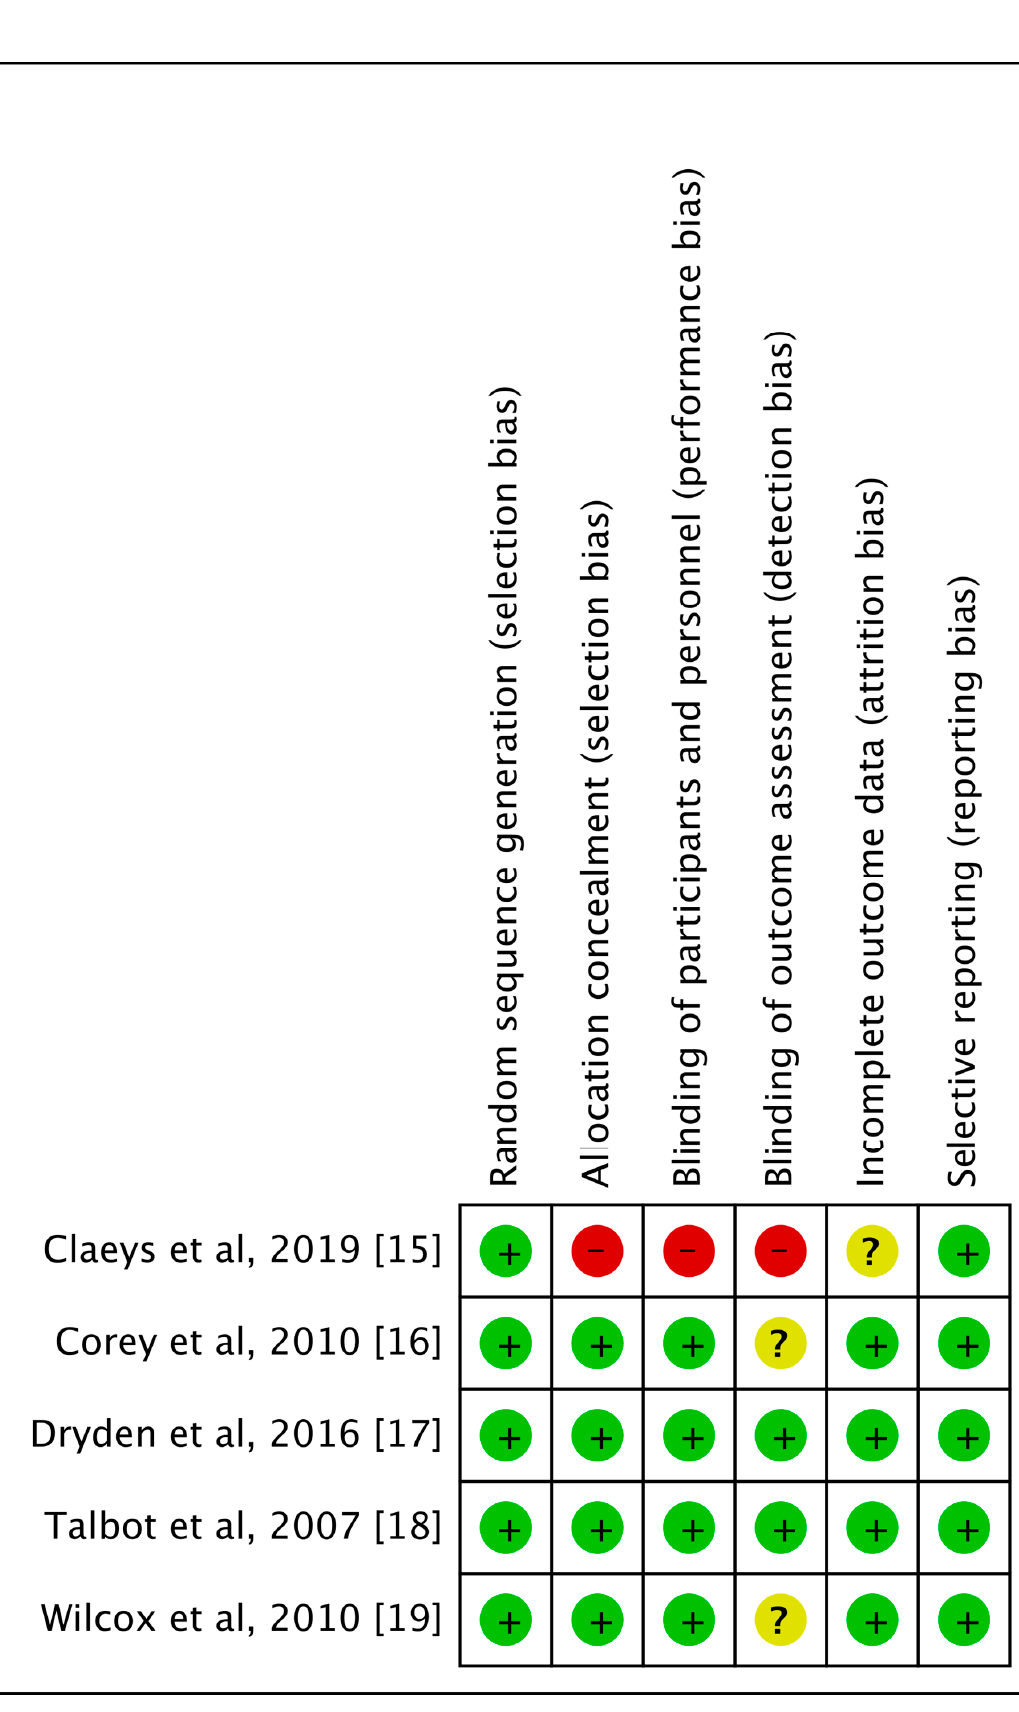
Figure 2. Risk of bias per study and domain.